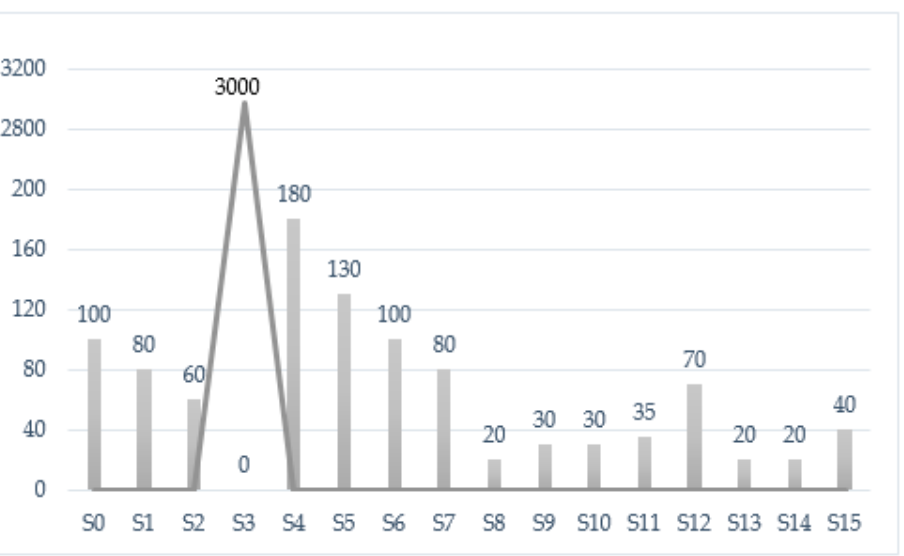
Figure 15. Electromagnetic wave power density for C 3 to S 0 , S 1 , …, and S 15 .